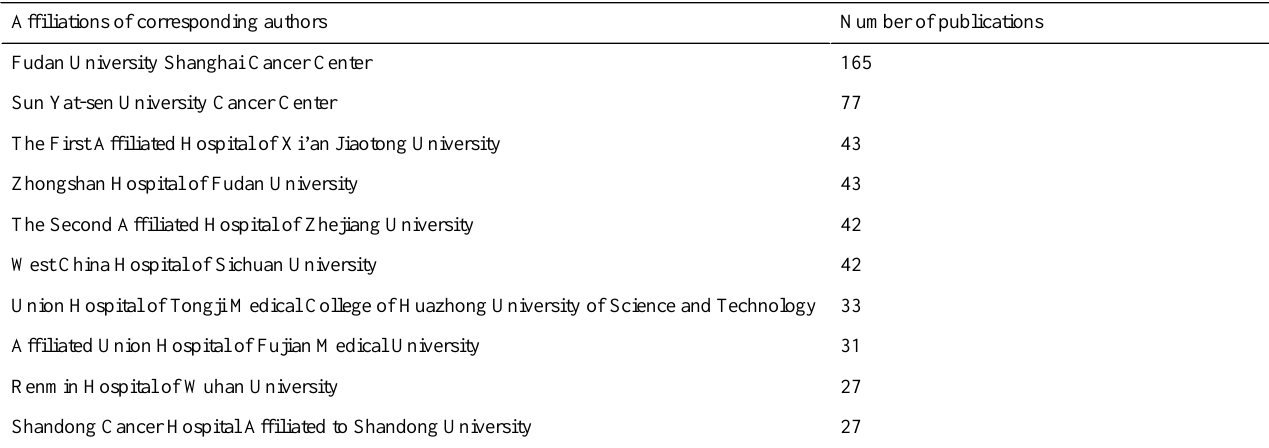
Table 3. Top 10 affiliated organizations of the most contributing corresponding authors.